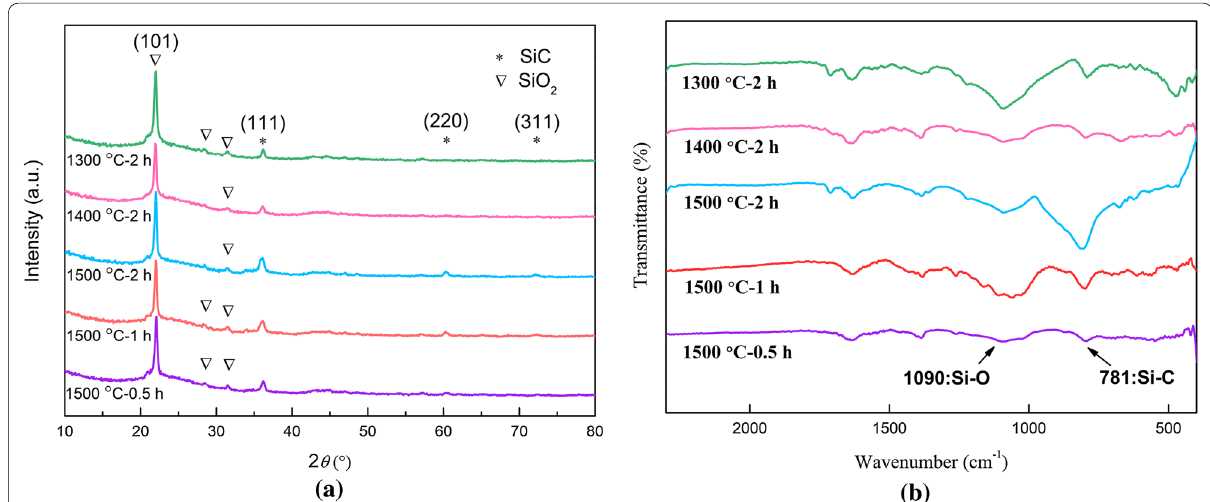
Fig. 3 a XRD patterns of R–SiC prepared at different temperatures and retention times; b FT-IR spectra of R–SiC prepared at different temperatures and retention